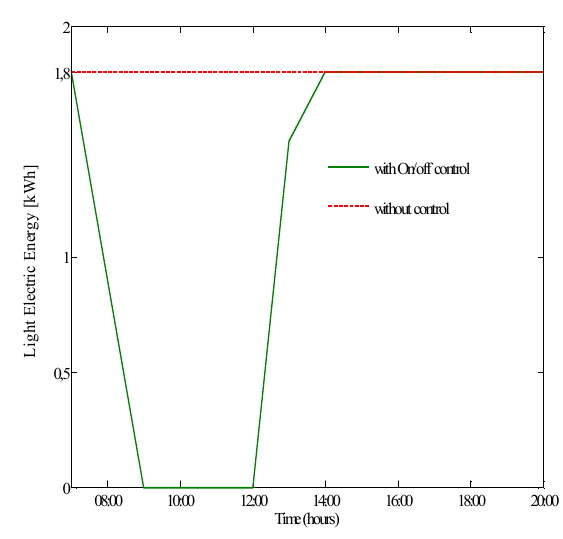
Figure 4. Electricity consumption of the lighting with on/off control Figure 5. shows the energy savings at different times of the day with the dimming and on/off control. Energy 80% with the dimming control.